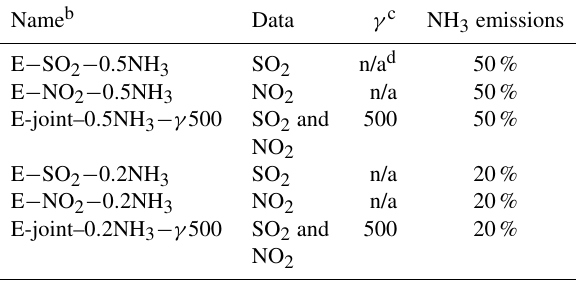
a Data quality control and observation errors are the same as E-joint in Table 1. b See description of these names in detail in Sect. 3.2. c γ is a parameter used to balance SO 2 and NO 2 observation terms in the cost function. d n/a stands for not